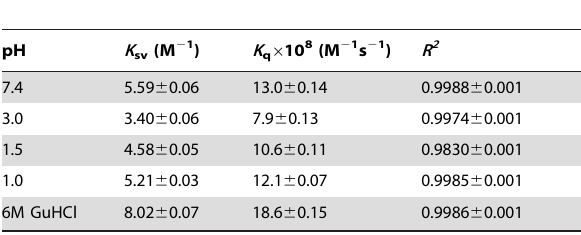
Table 2. Acrylamide quenching data of chymopapain at different pH and under denatured condition.